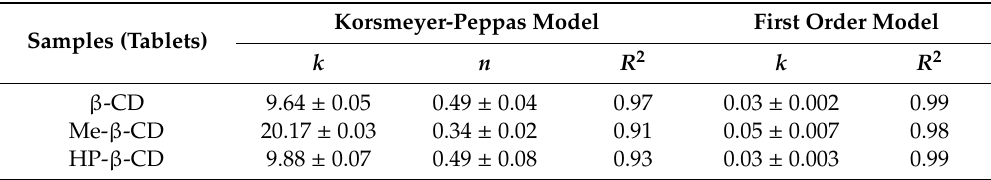
Table 2. Curve fitting